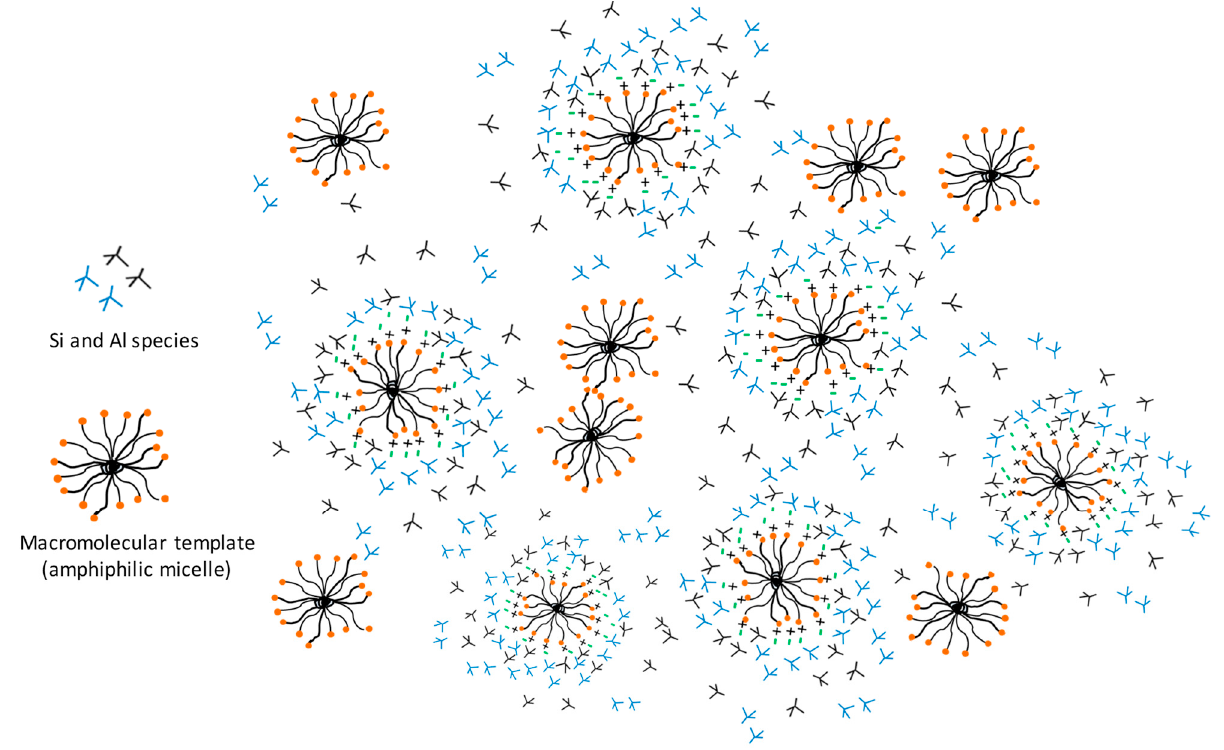
Figure 7. The schematic representation of macromolecular surfactant encapsulated gradually by Si and Al species to form mesopores in the final zeolite structure.